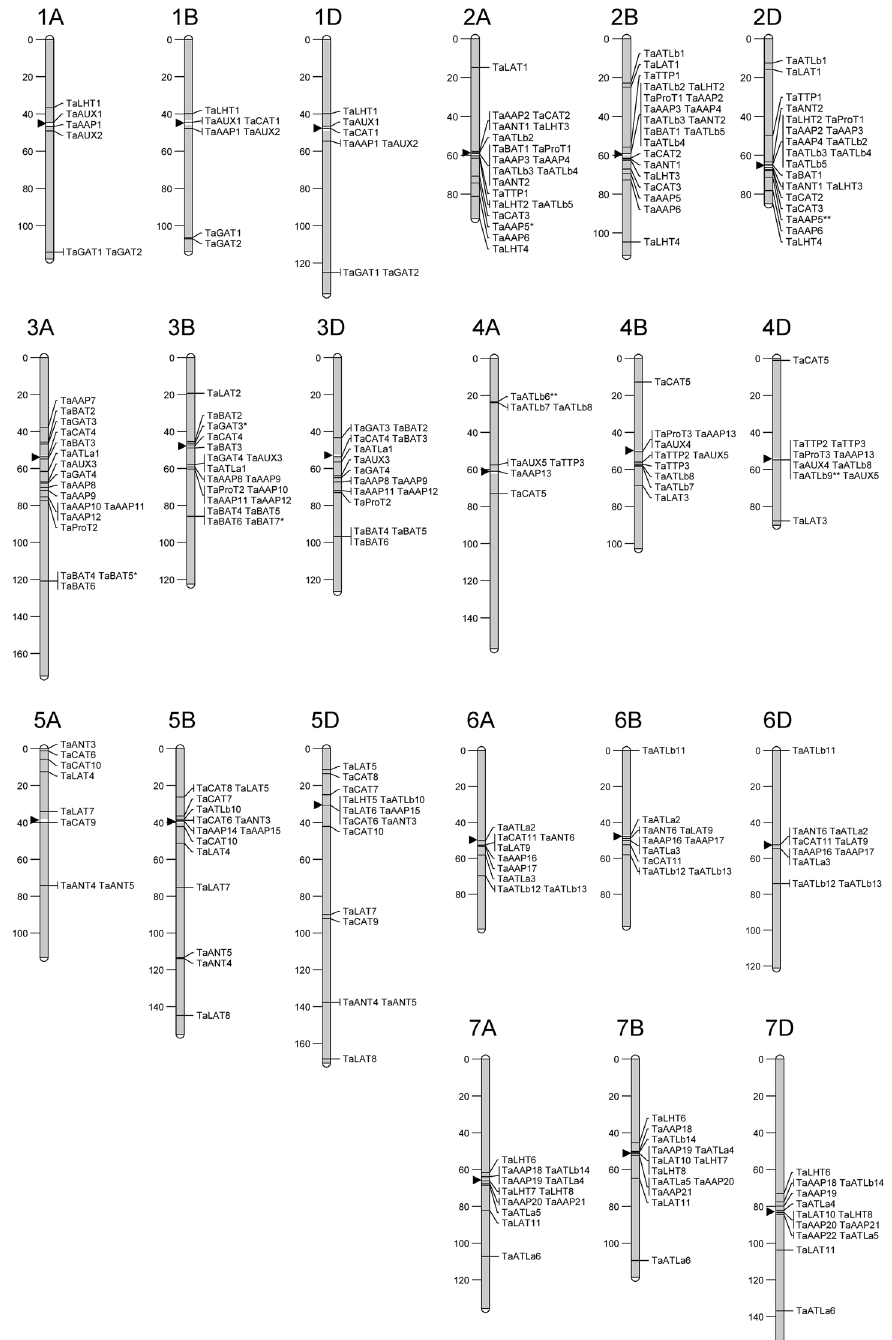
Figure 1. The distribution of AATs on wheat chromosomes using the genetic mapping distance, cM. The centromeres are indicated by arrowheads. The chromosomal positions used to generate the image are shown in Supplementary Table